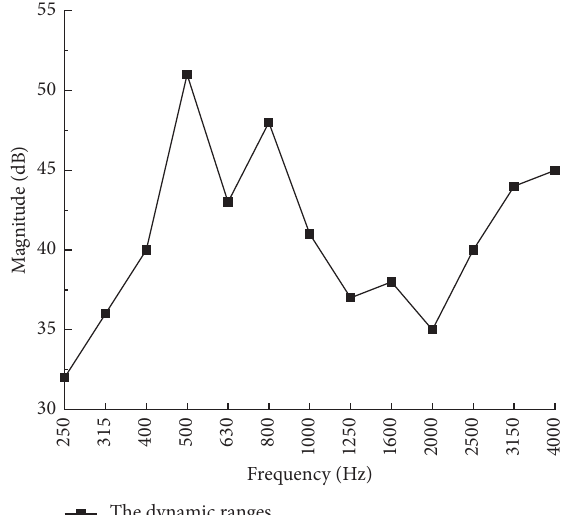
Figure 2: Microphone positions of array.